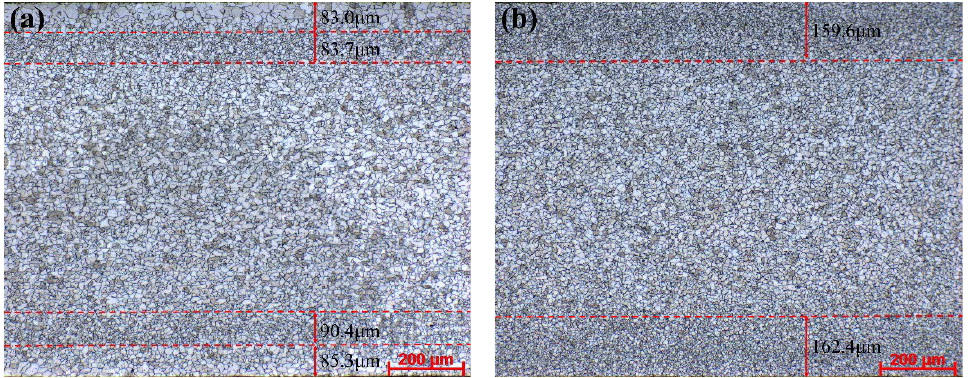
Figure 2. OM microstructure of different C content for 1.0 mm thickness. ( a ) ELC; ( b ) LC.